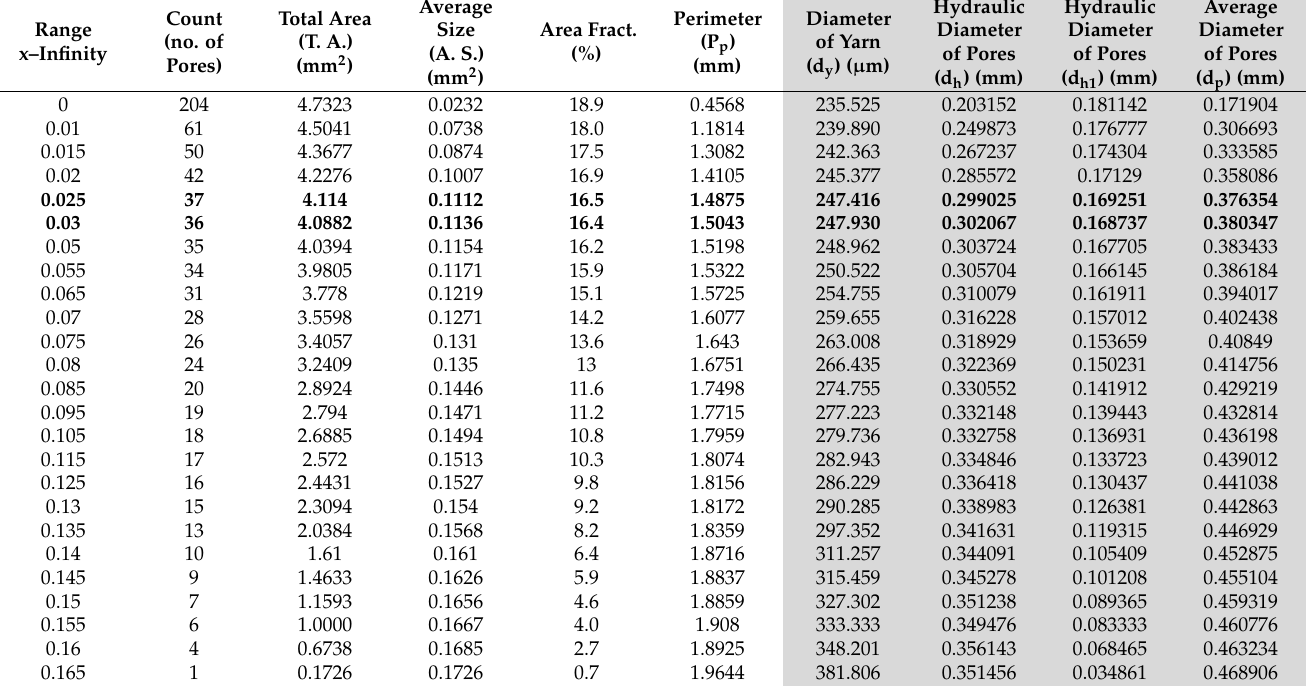
Table 4. ImageJ processed measurements and basic calculation for basket weave.